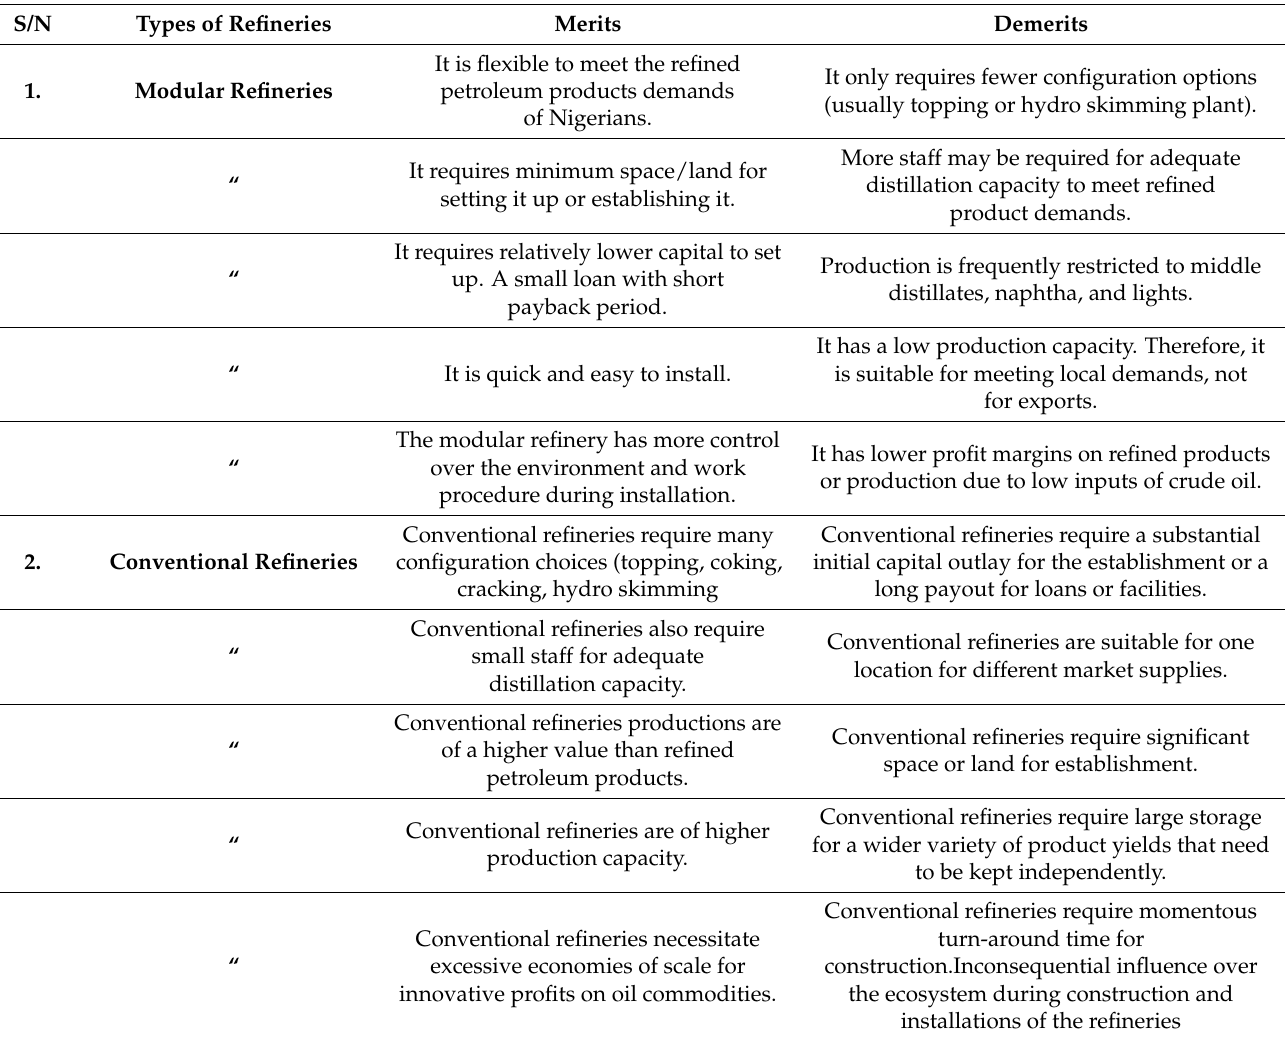
Table 1. Advantages and Disadvantages of Modular and Conventional Refineries in